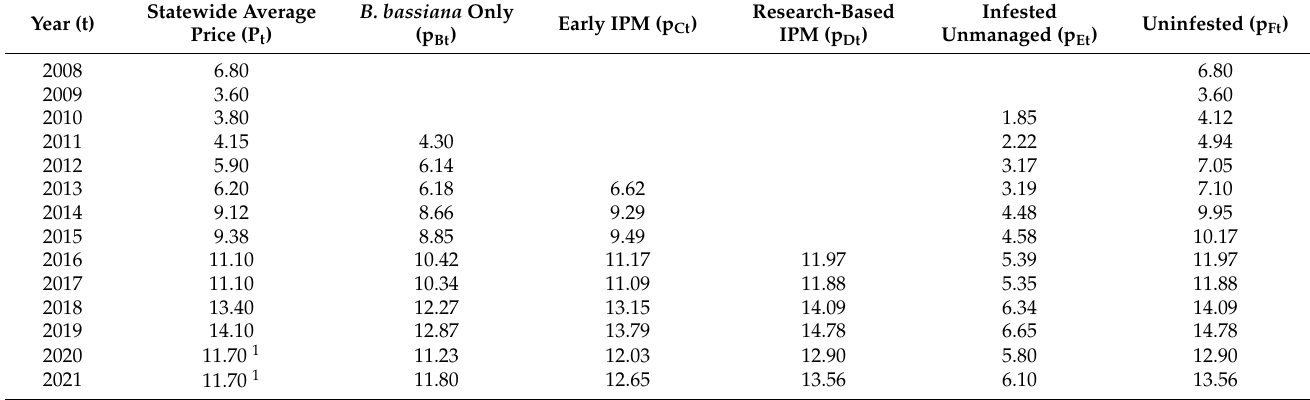
Table 2. Hawaii statewide average coffee price (USD) per pound for parchment coffee from 2008 to 2021, and statewide price based on various management